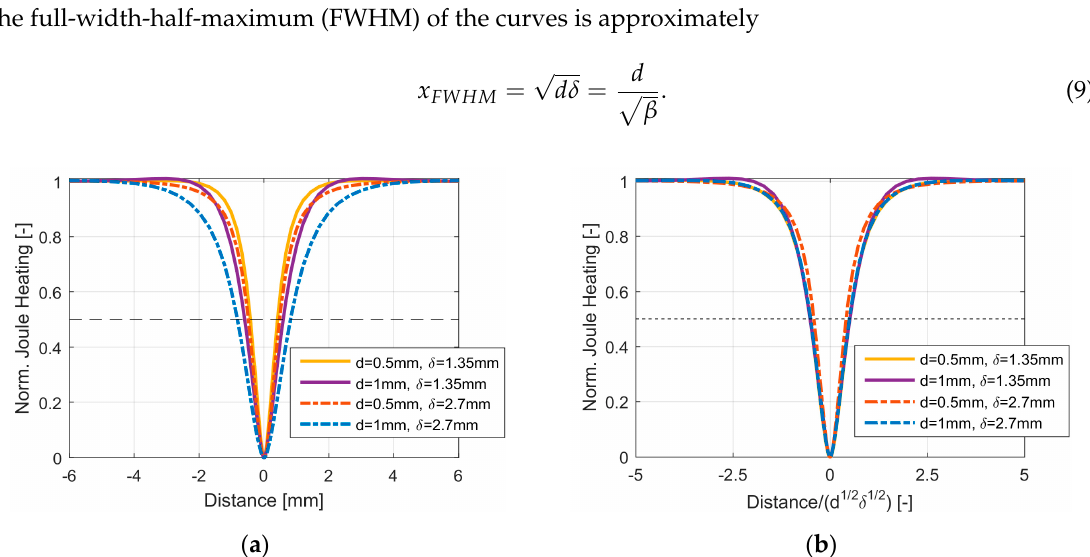
Figure 19. Joule heating at the surface for d = 0.5 and 1 mm crack depths and for two different penetration depths depending on the distance ( a ) and abscissa normalized to δ d ( b ).